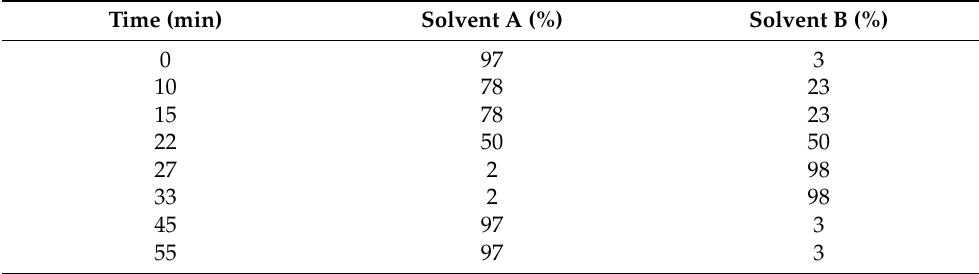
Table 8. Gradient for HPLC